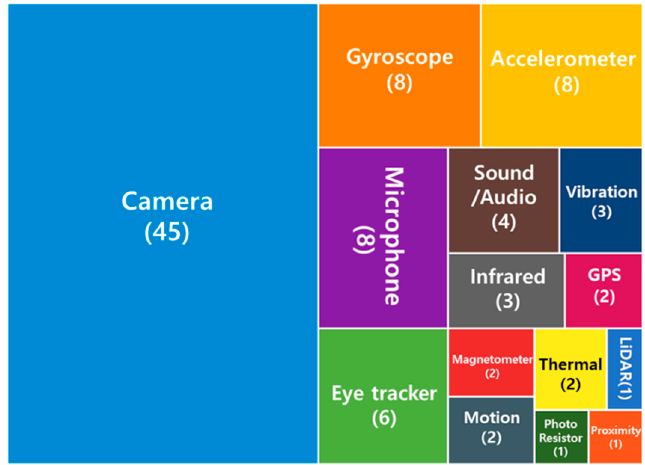
Figure 16. Frequency and ratio of each sensor used in the study. Figure 15. Frequency and ratio of each sensor used in the study.